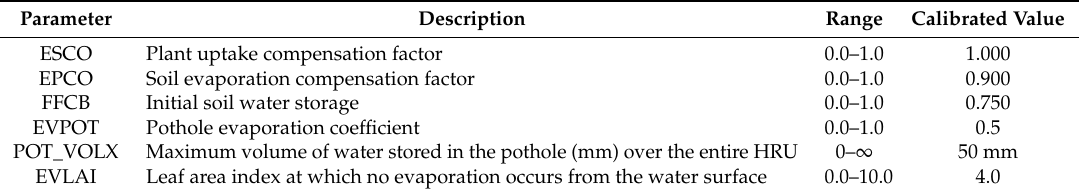
Table 3. Calibrated values of the selected Soil and Water Assessment Tool (SWAT) hydrologic parameters. Parameter